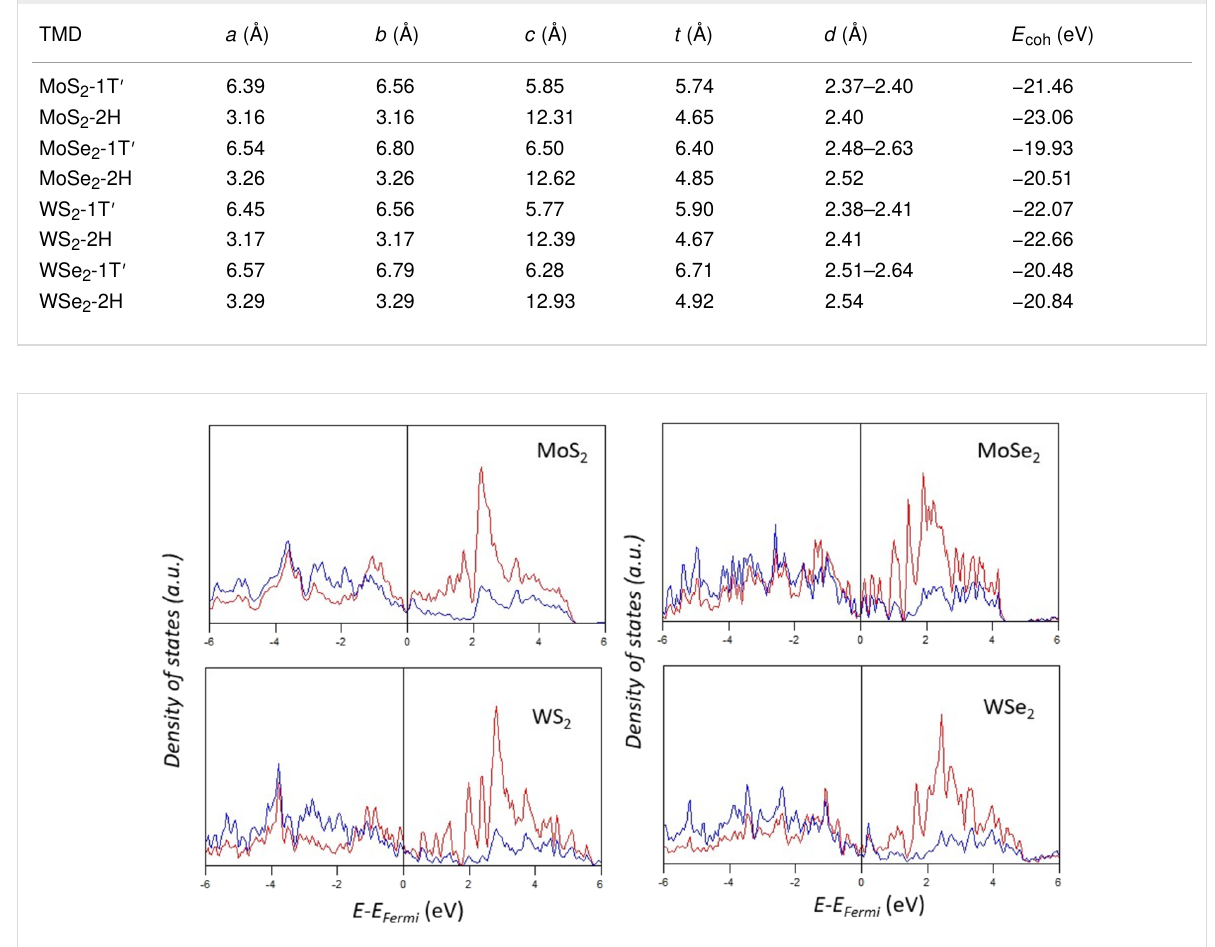
Figure 2: Partial DOS of the Mo 4d or W 5d states (red line), S 3p and Se 4p states (blue line) of 1T ′